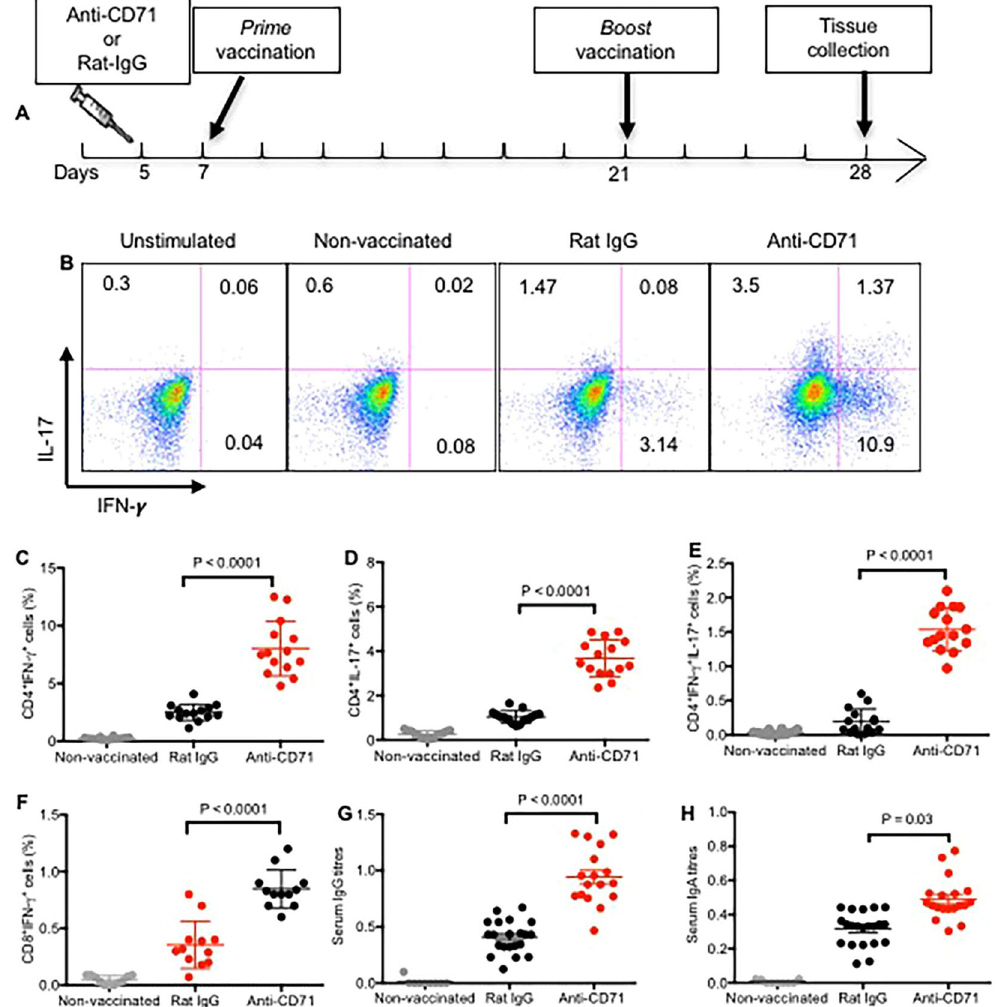
Figure 5. Depletion of CD71 + cells enhances IL-17, IFN- γ secreting and antibody producing adaptive immune cells following immunization. ( A ) The cartoon shows treatment and vaccination time points. ( B ) Representative plots showing IL-17 and IFN- γ producing CD4 + T cells among splenocytes following stimulation with HKBP for 6 h. ( C ) Percent CD4 + T cells secreting IFN- γ ; ( D ) secreting IL-17 and ( E ) secreting IFN- γ and IL-17 following stimulation with HKBP for 6 h. ( F ) Percent CD8 + T cells secreting IFN- γ among splenocytes following stimulation with HKBP for 6 h. ( G ) Anti- B. pertussis -specific IgG antibody in serum, ( H ) anti- B. pertussis -specific IgA antibody in serum of either treated mice with anti-CD71 or isotype control group were measured by ELISA as described in methods. Each point represents data from an individual mouse, representative of three independent experiments. Bar, mean ± one standard